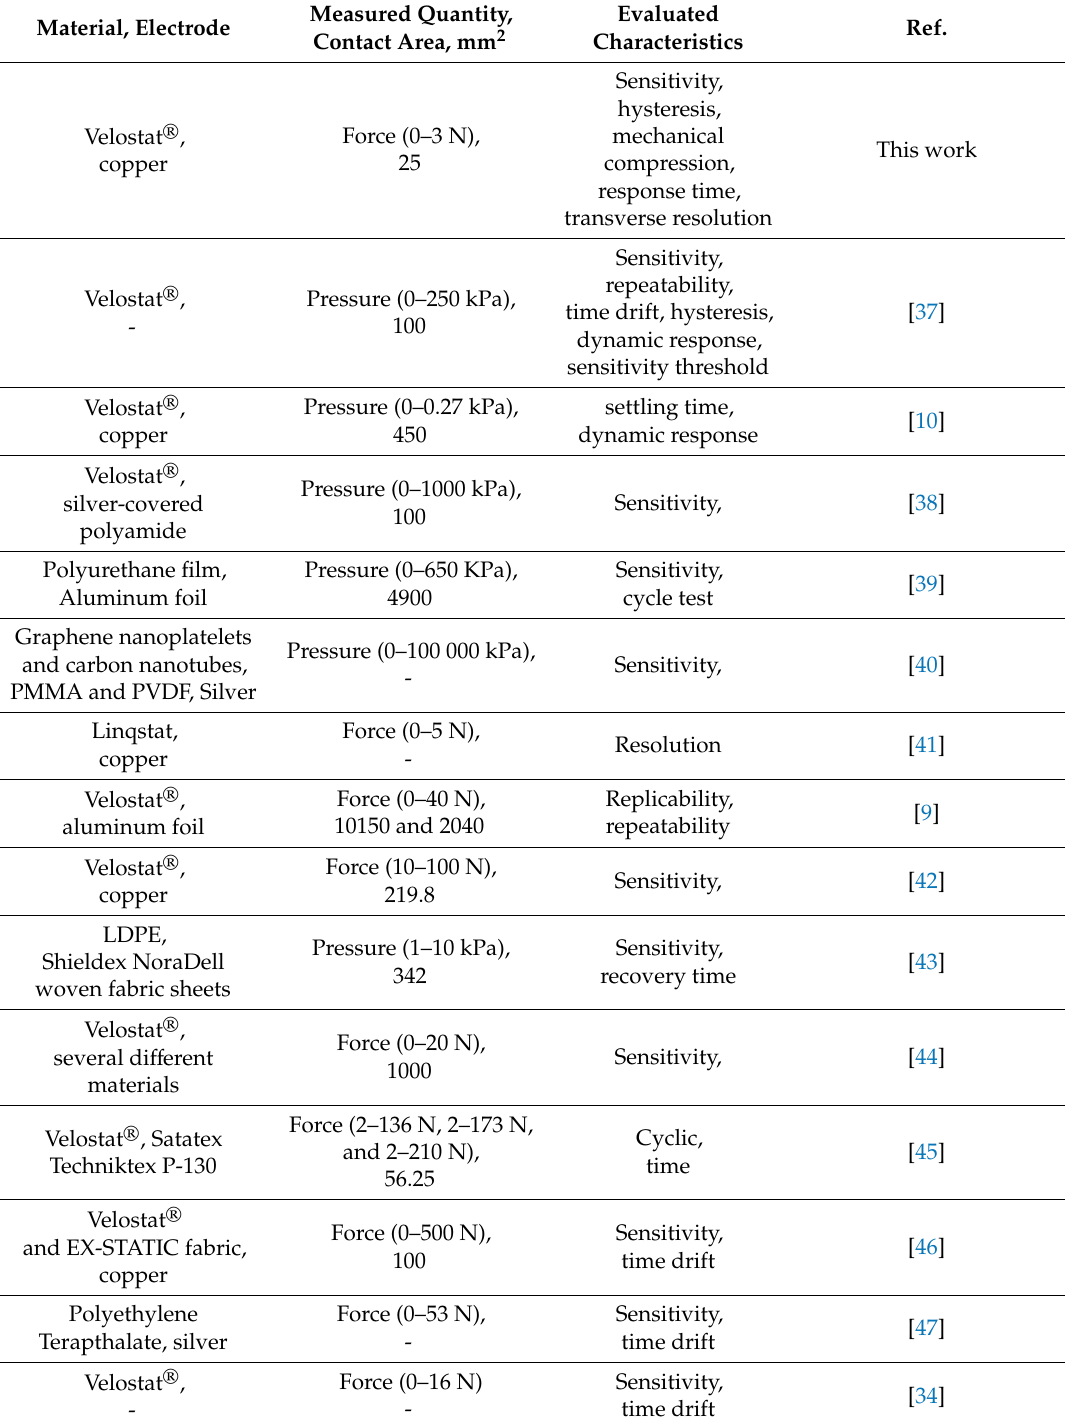
Table 1. Piezoresistive sensors design and their